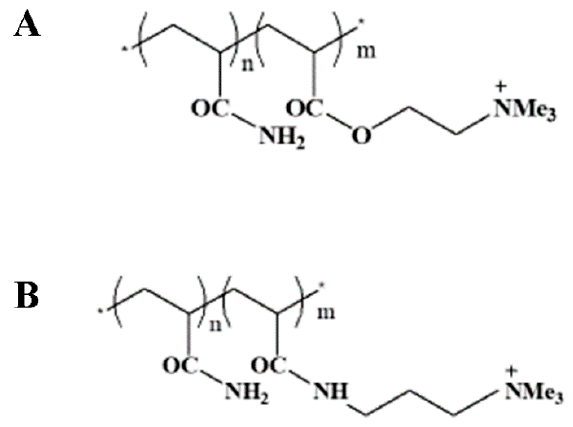
Figure 1. Cationic PEs: ( A ) conventional and ( B ) hydrophobic.